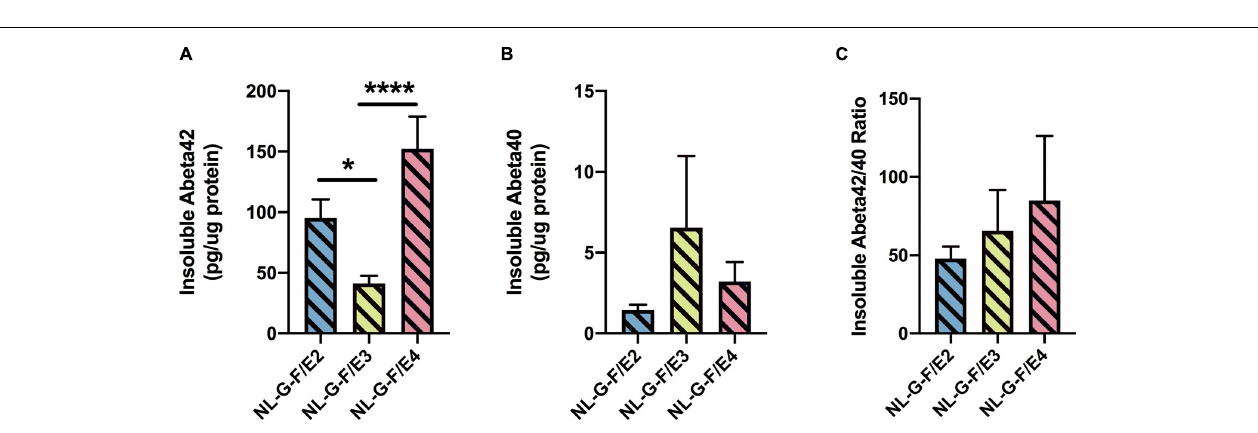
FIGURE 5 | females. & p < 0.05. In addition, NL-G-F/E2 females showed lower baseline activity than E2 females. ∧ p < 0.05. In contrast NL-G-F/E3 females had higher baseline activity levels than E3 females. & p < 0.05. There was a trend toward a lower baseline activity in NL-G-F/E4 than E4 females ( p = 0.066). (C) There was an effect of APOE on motion during the shocks of males. E2 males responded less in response to the shocks than E3 and E4 males. @ p < 0.05. (D) There was an effect of APOE on motion during the shocks of females. E2 females responded less in response to the shocks than E3 and E4 females. @ p < 0.05. In addition, NL-G-F females responded less to the shocks. * p < 0.05. (E) There was an effect of APP on freezing during the tones. While NL-G-F mice froze more during the first tone, they froze less during the second tone. (F) Freezing during the tones of females. (G) There was an effect of APOE, APP, and an APP × APOE interaction for freezing of males during the ISIs. E4 males froze more during the ISIs than NL-G-F/E4 males. o p < 0.05. (H) There was an APP × APOE interaction for freezing of females during the ISIs. While NL-G-F/E4 females froze more than E4 females during the first ISI, they froze less than E4 females during the second ISI. (I) There was an APP × APOE interaction for freezing of males during the contextual memory test. NL-G-F/E3 males froze less than E3 males in the contextual memory test. * p < 0.05. In addition, NL-G-F-E2 males froze more than NL-G-F/E3 males in the contextual memory test. (J) There was an effect of APOE on contextual fear memory in females. E2 females froze more than E3 females in the contextual memory test. & p < 0.05. (K) There was an effect of APOE on cued fear memory in males. E2 males froze less than E3 and E4 males in the cued fear memory test. @ p < 0.05. (L) Cued fear memory of females.